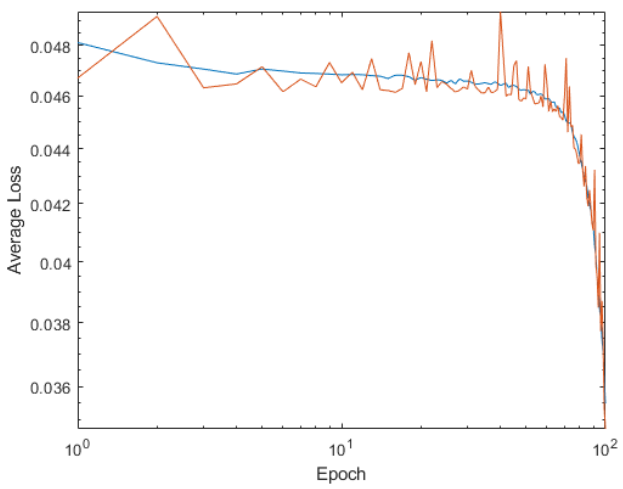
Figure 23. Unified best learned patterns cos(φ) on the ( left ) and | 𝜕𝐿𝑜𝑠𝑠 | on the ( right ) for the Cross-in-Tray function using the dynamic alpha and drop-out. 𝜕𝑊 𝑛